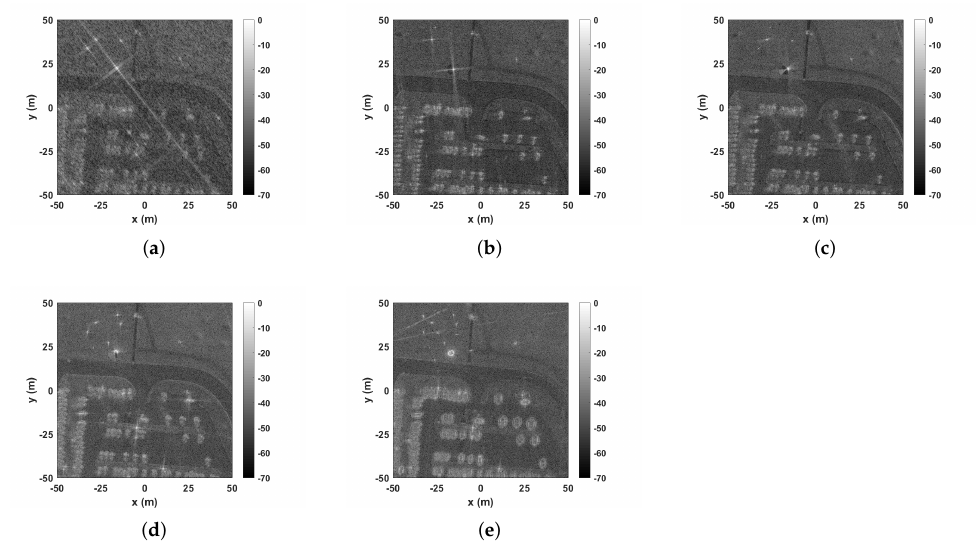
Figure 12. Images generated using the backprojection algorithm and the Gotcha Volumetric SAR dataset at different azimuth angles: 39º, 1–10º, 1–50º, 1–100º and 1–360º. ( a ) GOTCHA Volumetric dataset image generated using the backprojection algorithm at 39º azimuth. ( b ) GOTCHA Volumetric dataset image generated using the backprojection algorithm from 1º to 10º azimuth. ( c ) GOTCHA Volumetric dataset image generated using the backprojection algorithm from 1º to 50º azimuth. ( d ) GOTCHA Volumetric dataset image generated using the backprojection algorithm from 1º to 360º azimuth. ( e ) GOTCHA Volumetric dataset image generated using the backprojection algorithm from 1º to 100º azimuth.